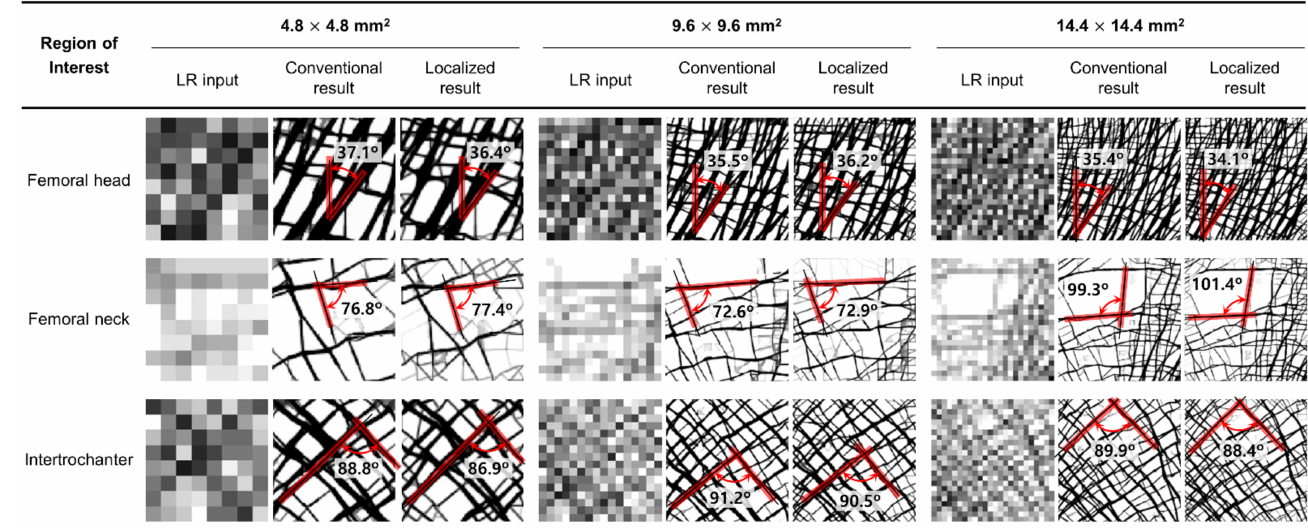
Figure 4. Trabecular architecture comparison of the low-resolution input (first column), the result of the conventional method (second column), and the result of the localized method (third column) according to the three different ROI locations and sizes.